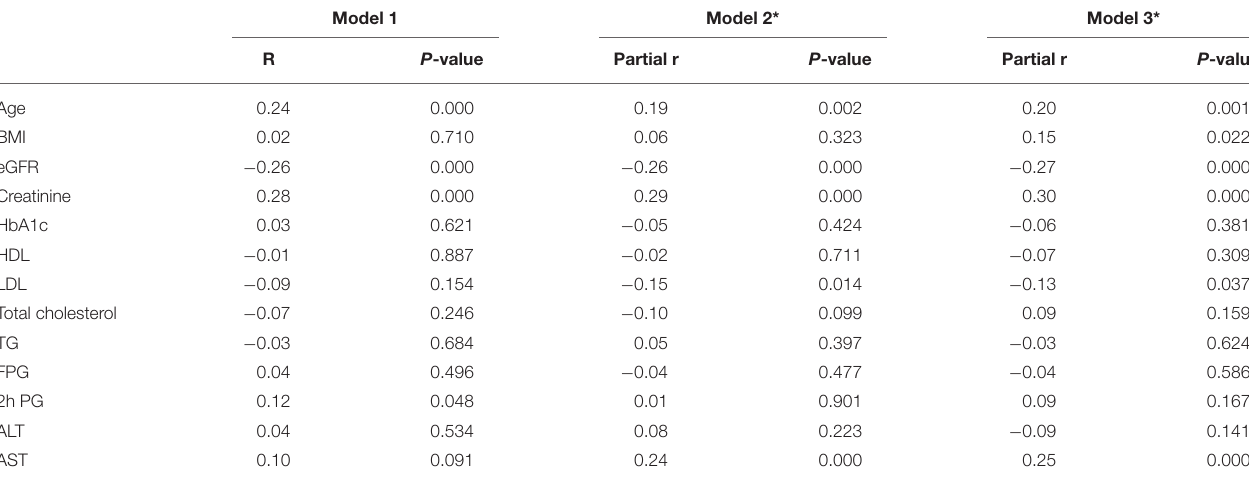
TABLE 3 | Partial correlations between ANGPTL8 levels and clinical variables.